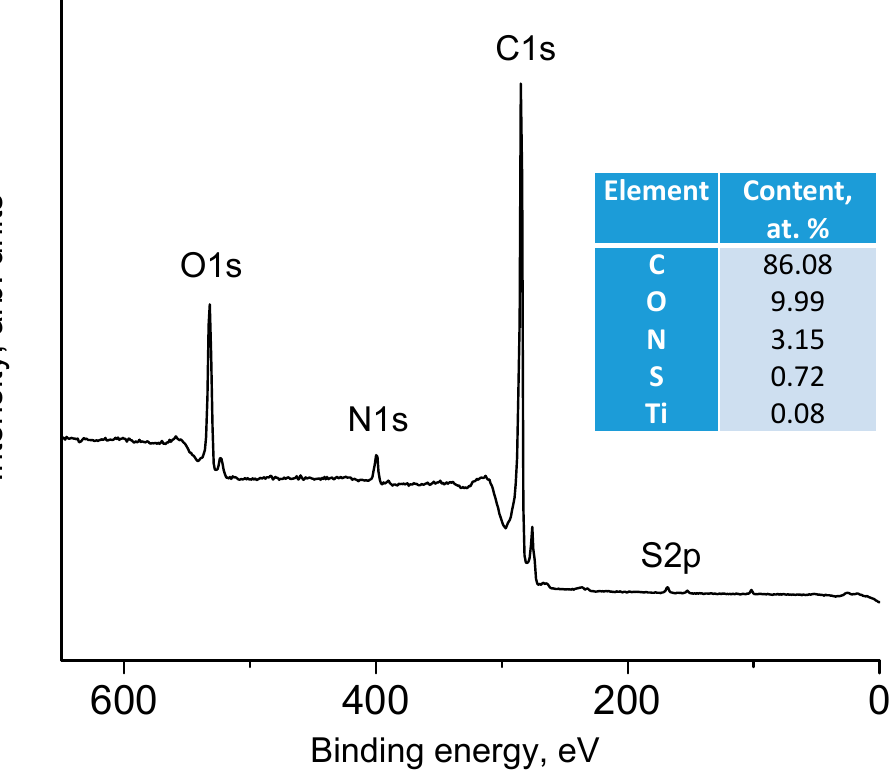
Figure 2. Survey XPS spectrum of the nanocomposites containing 15 mass % TiO 2 . Insertion: elemental composition of the sample surface.